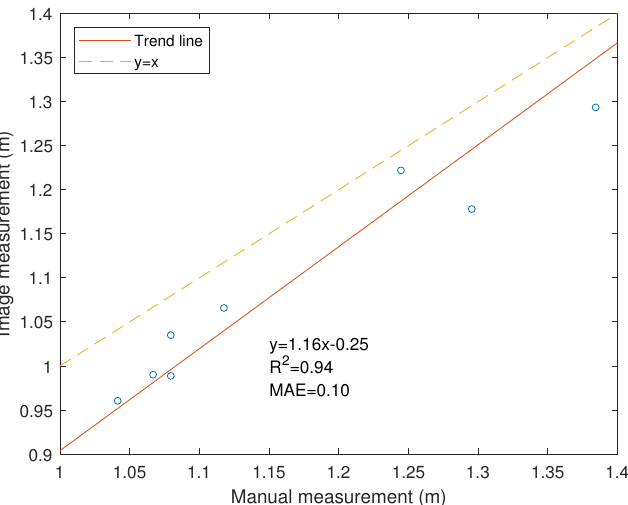
Figure 19. Correlation between maximum canopy height derived from images and maximum canopy height manually measured in the